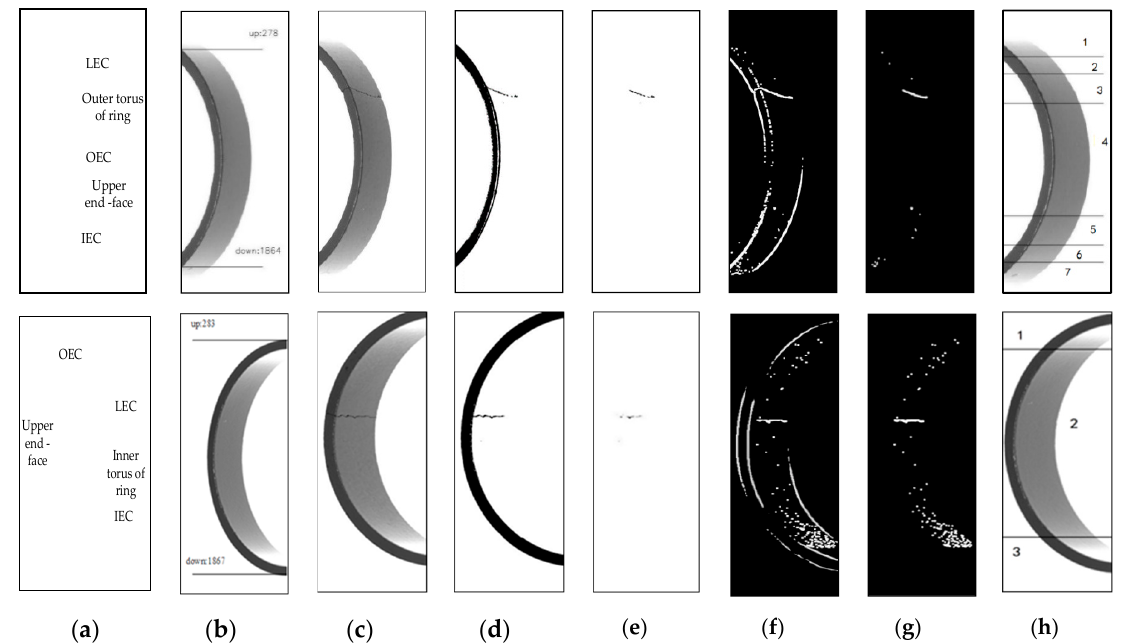
Figure 8. Torus image processing: ( a ) annotation of torus images; ( b ) location result; ( c ) original defect image of torus (2056 × 600); ( d ) torus gray binary image; ( e ) edge-removed torus gray binary image; ( f ) torus gradient binary image; ( g ) edge-removed torus gradient binary image; ( h ) segmentation of torus images.